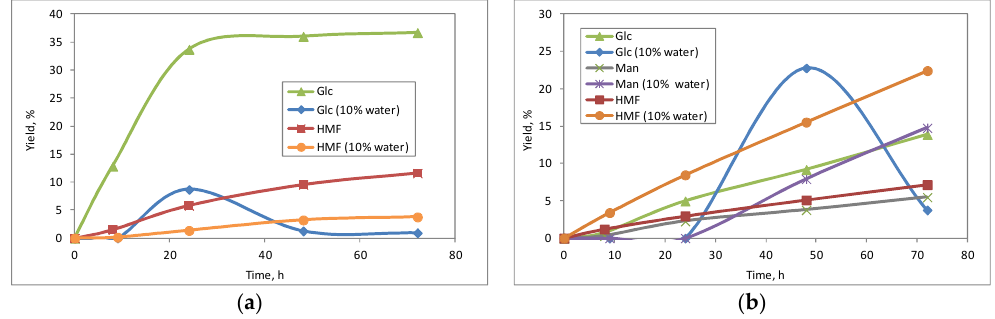
Figure 6. Conversion of cellulose to glucose, mannose and HMF in [BMIM]Cl at 100 °C in the presence of water (10 wt % of solvent) by using POMs based on ( a ) tungsten oxide, ( b ) molybdenum oxide. Catalyst loading was 10 wt % from cellulose and cellulose loading was 10 wt % from solvent. Tungsten (VI) and molybdenum (VI) are expected to form POMs with imidazolium-based ILs. POMs are a class of anionic metal-oxygen clusters built by the connection of [MO]x polyhedral of the early transition metals in their highest oxidation states [38].